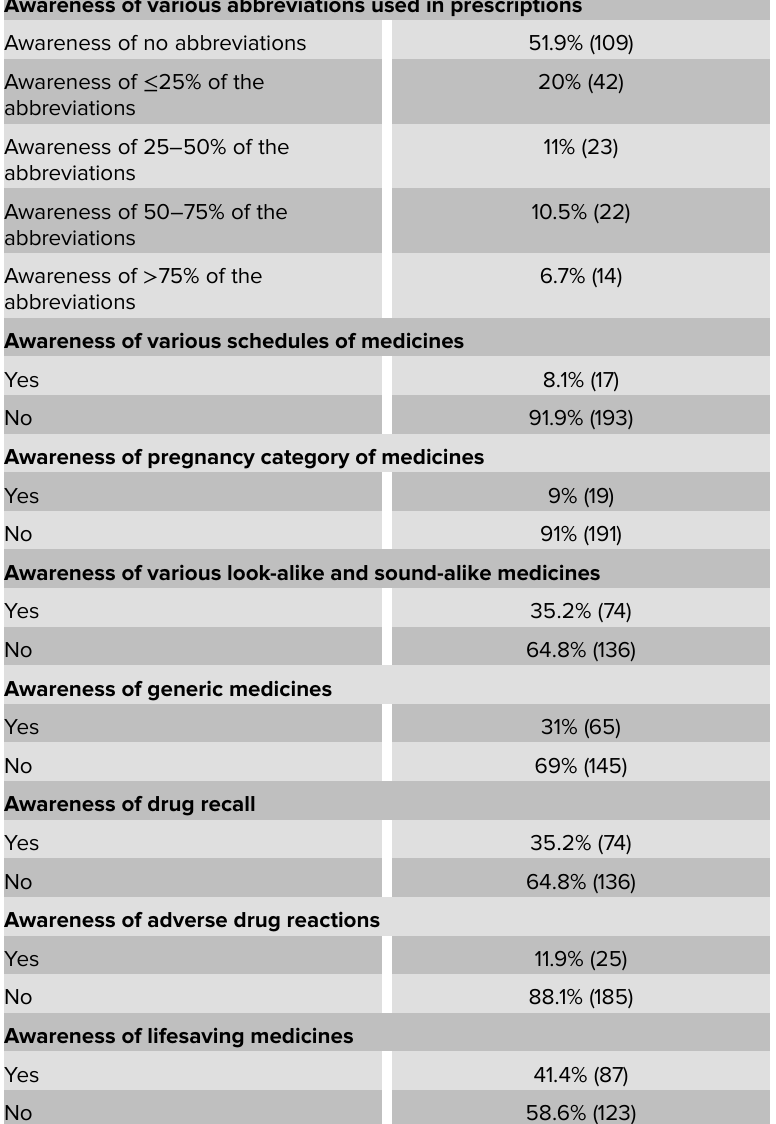
TABLE 4: Awareness regarding various essentials of pharmacy